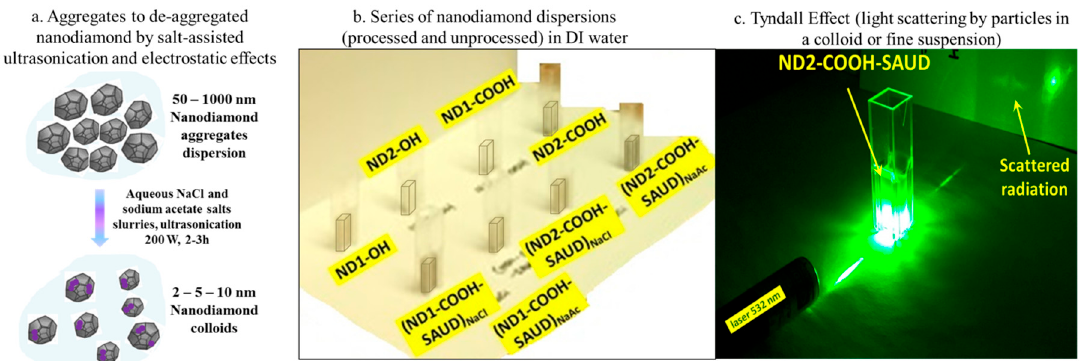
Figure 1. ( a ) Scheme of de-aggregation of nanodiamond following salt-assisted ultrasonication. The salts used are sodium chloride (NaCl) and sodium acetate (CH 3 COONa); ( b ) The series of nanodiamond dispersions and ( c ) Tyndall effect—light scattering by a representative de-aggregated nanodiamond (ND2-COOH-SAUD) colloid.